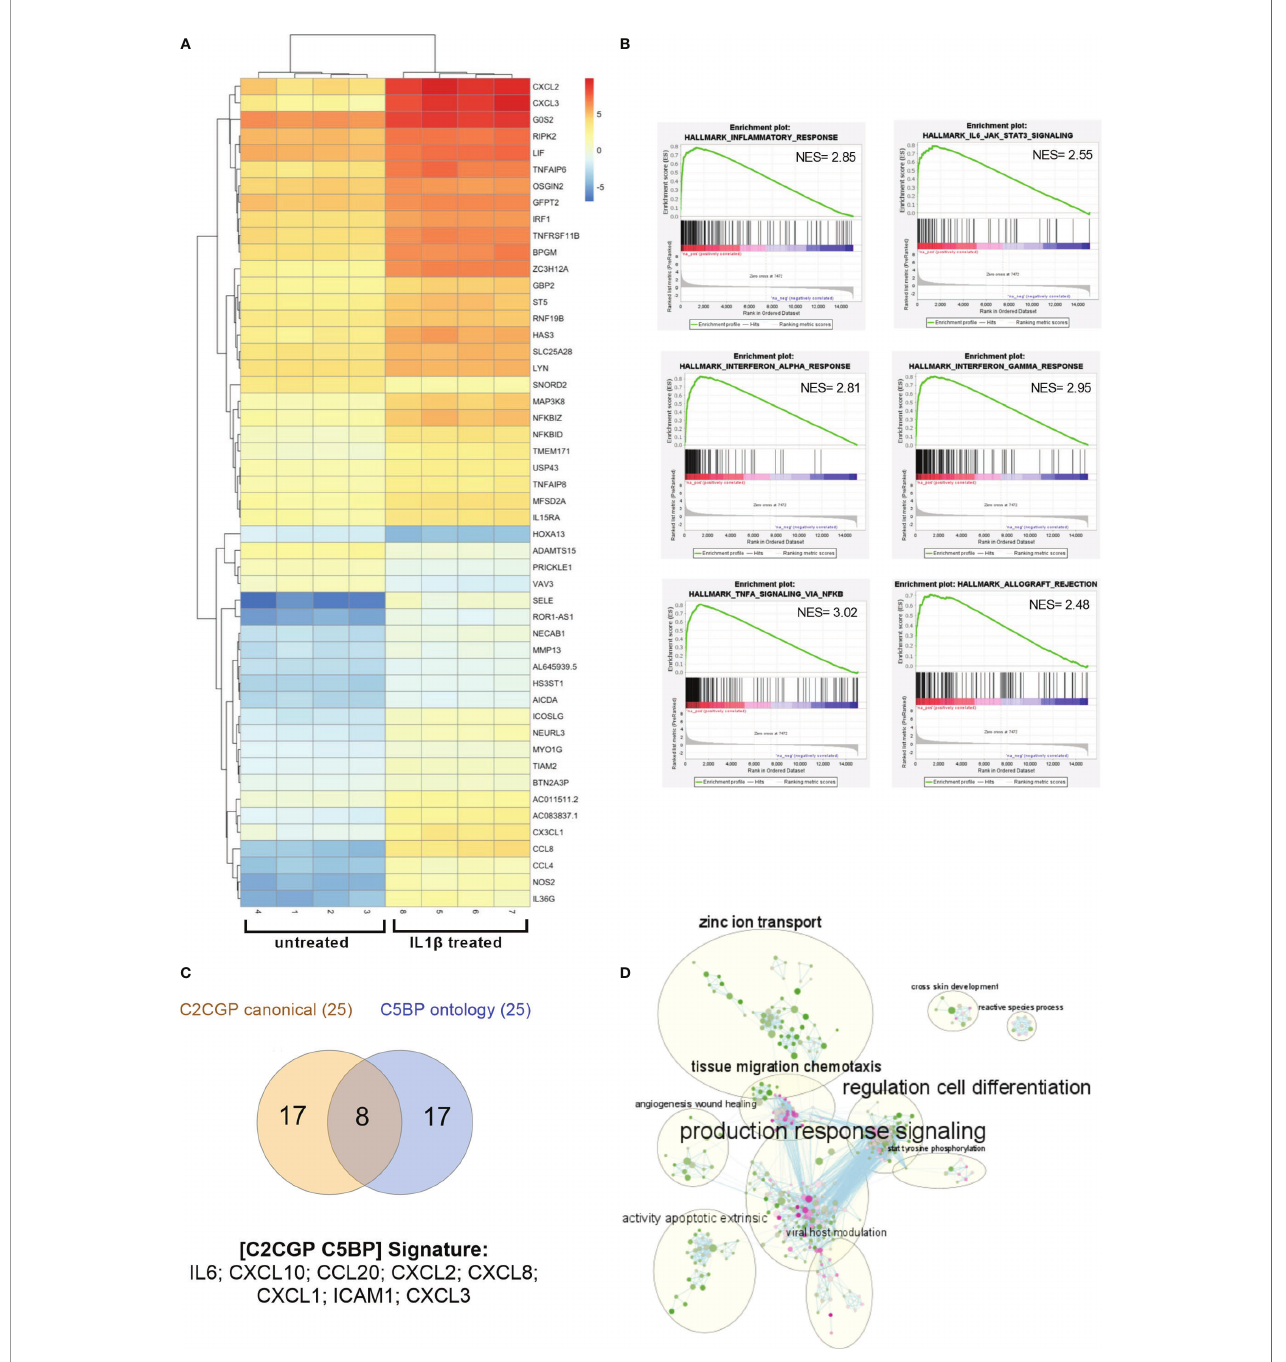
FIGURE 3 | Gene expression pro fi le in RCC cells after IL1 stimulation. (A) Heat map showing the clustered expression values of top 50 DEGs between treated with IL1 b and control groups of A498 RCC cells. Genes are fl agged as “ differentially expressed ” if they satisfy both the following conditions: nominal p-value < 0.01 and LogFC >1. Values have been scaled on rows. Color key is displayed on the right of the heat map. (B) Enrichment plots for selected hallmark gene sets found positively enriched in A498 treated with IL1 b . The gene set name is shown at the top of the enrichment plot, the green curve represents the running enrichment score, and the black bars indicate the positions of the gene set hits on the rank ordered list in GSEA. The highest signal-to-noise values are indicated with red color, and blue indicates the lowest ones. (C) Venn diagram shows the shared upregulated genes obtained from leading edge analysis with GOBP and canonical pathways. (D) Enrichment map of GOBP enrichment analysis. The dots represent the node. The color and the size of the dots indicate respectively the NES values (from green 1.53 to pink 2.82) and the overlap size. The lines represent the link between nodes. The circles indicate the macro areas of similarity between nodes determined by AutoAnnotate. All the clusters with more than nine nodes are represented (except for “ glial population glycogenesis ” cluster with 10 nodes, not included